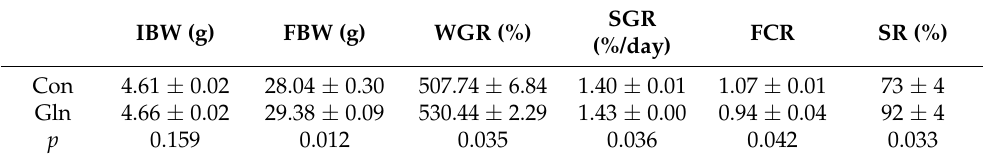
Table 3. Effects of glutamine on weight gain rate, specific growth rate, feed conversion rate of yellow catfish, and its survival rate after challenge with Flavobacterium columnare . All data were analyzed using student’s t -test